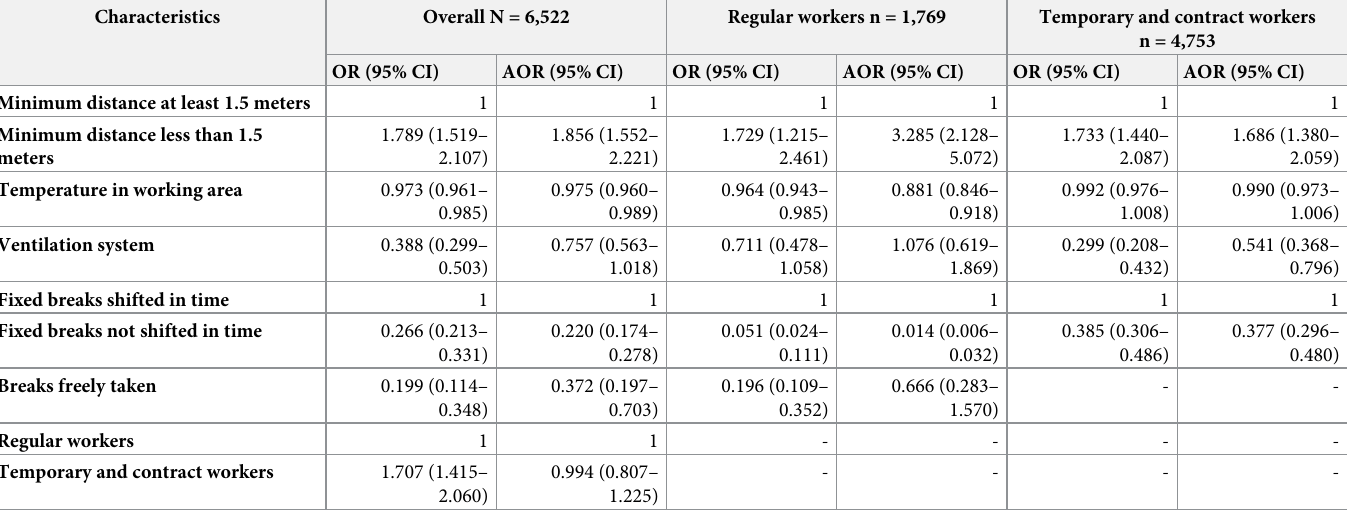
Table 5. Results of the logistic regression analysis for COVID-19 infections.